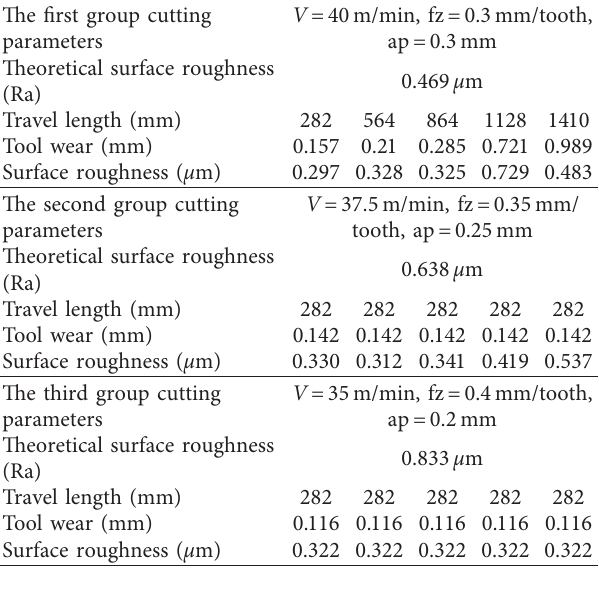
Figure 10: Impacts of cutting parameters on tool Table 3: Tool wear and surface roughness of Waspaloy for cutting parameters.